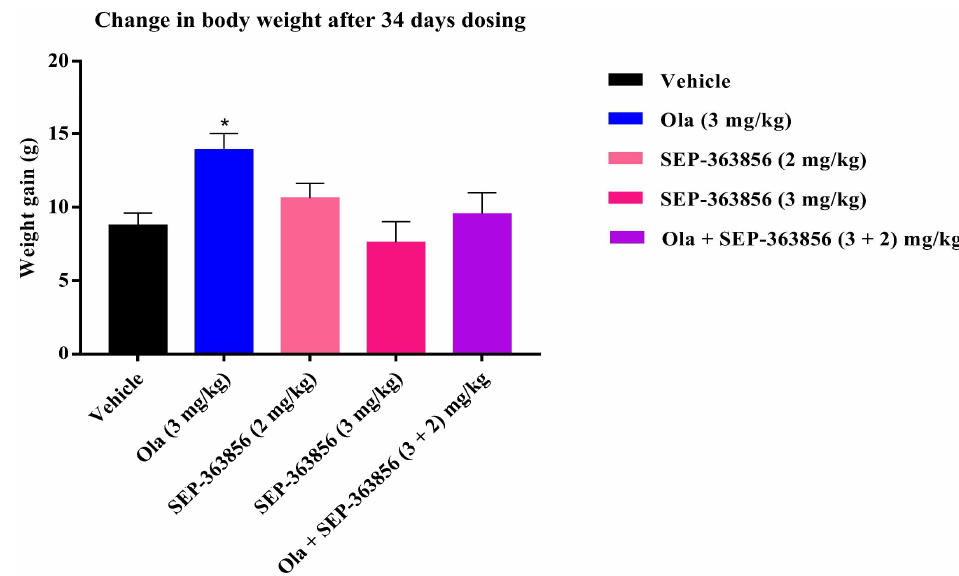
Figure 4. The effects of olanzapine (3 mg/kg, p.o.) and SEP-363856 (2, 3 mg/kg, p.o.) given alone or in combination with olanzapine (3 mg/kg) and SEP-363856 (2 mg/kg) on body weight gain over 34 days in female mice. Date expressed as mean ± S.E.M. ( n = 8). (* p < 0.05 vs. vehicle group).